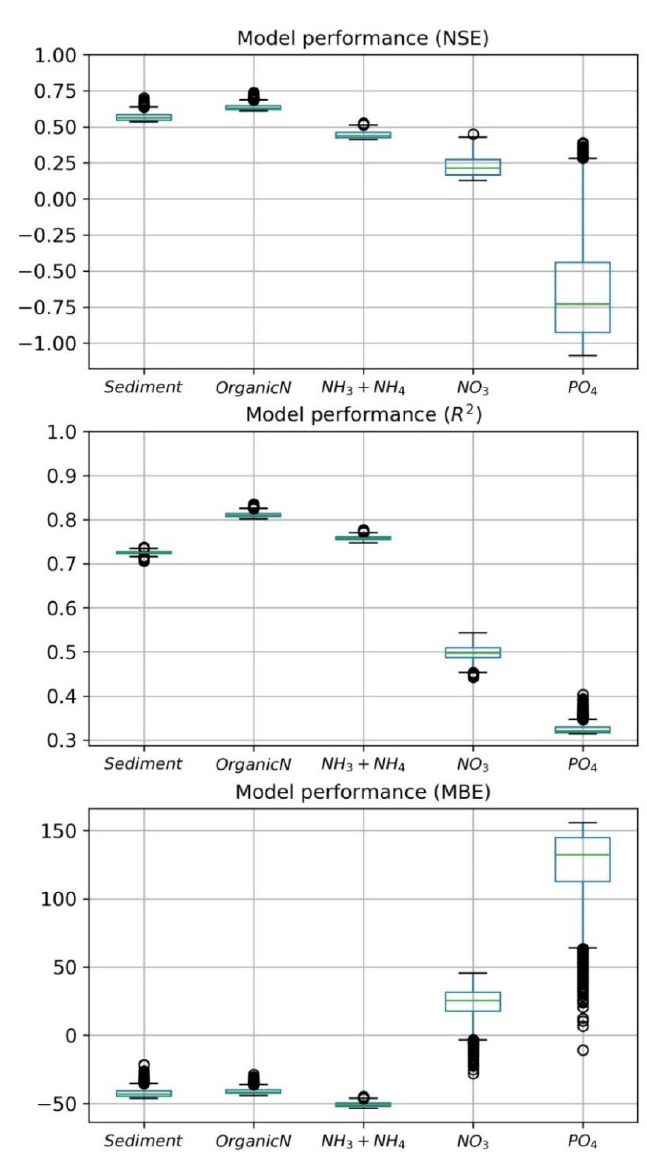
Figure 6. Model performance for behavioral runs: NSE, R 2 and MBE.